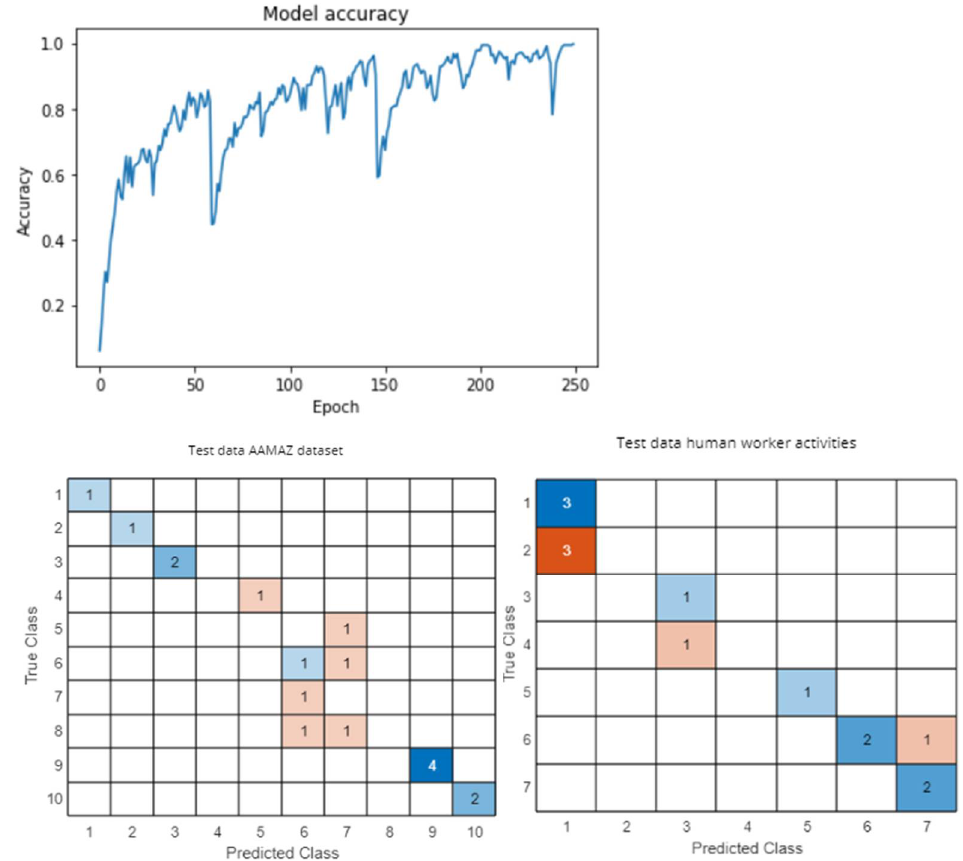
Figure 15. Model Figure 15. Model Performance.